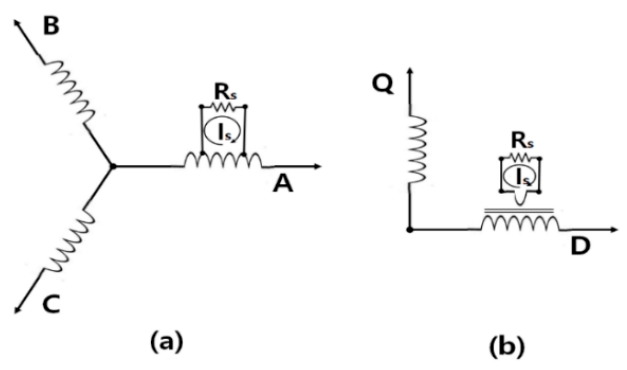
Figure 4. ( a ) Turn short in phase A, ( b ) D-Q Transformation equivalent model by turn short circuit. Shorted and unshorted windings have the same inductance, resulting in direct interference.